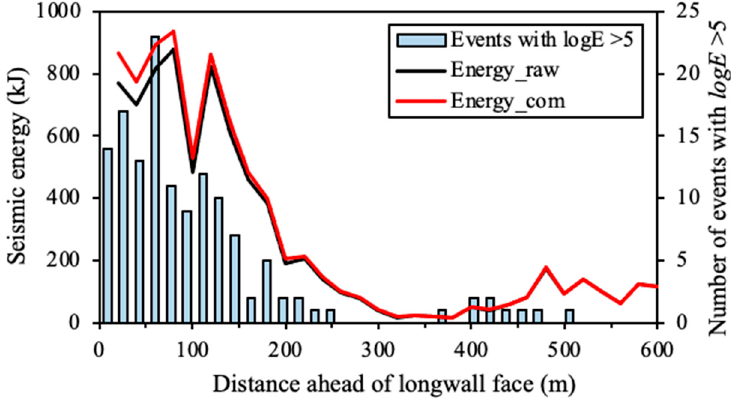
Figure 10. Distribution of average event counts ahead of the longwall face in LW250105 using the compensated seismic data ( Num com ) and raw seismic data ( Num raw ).